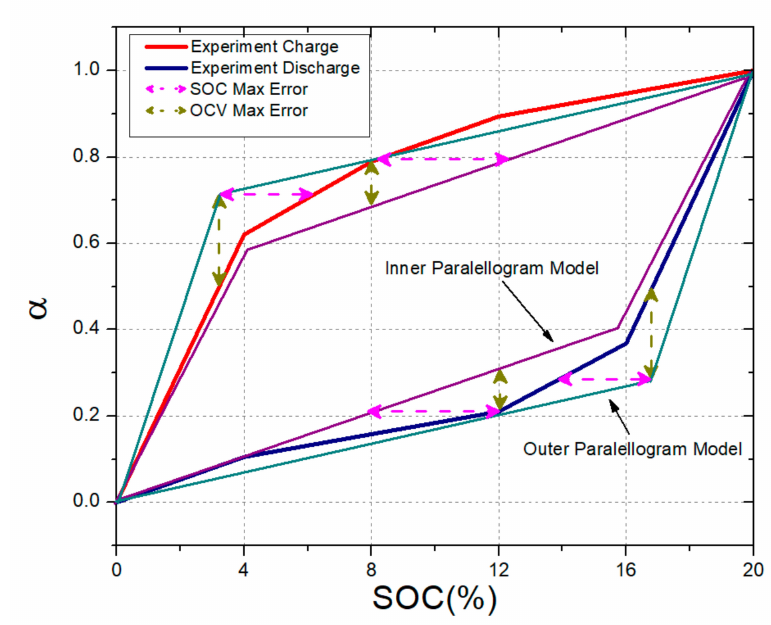
Figure 2. Parallelogram method for hysteresis modeling.